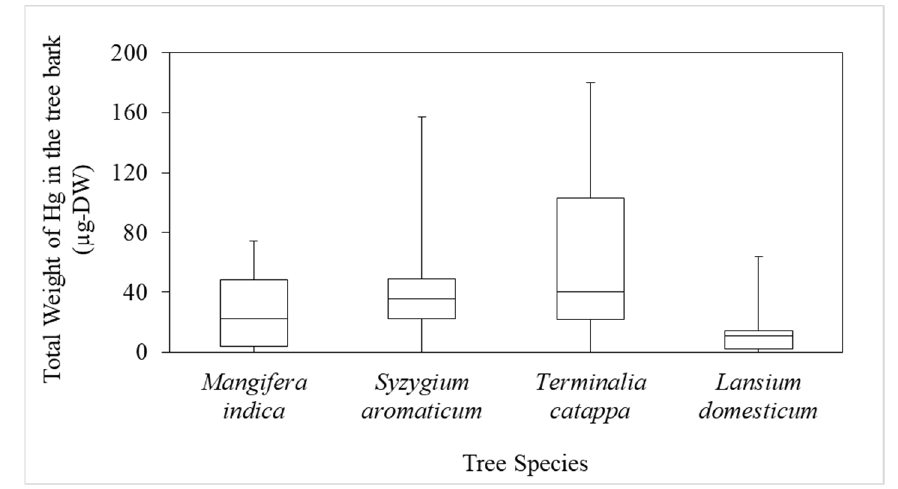
Figure 5. Boxplot of the total weight of Hg (THg) in the bark of the various species.